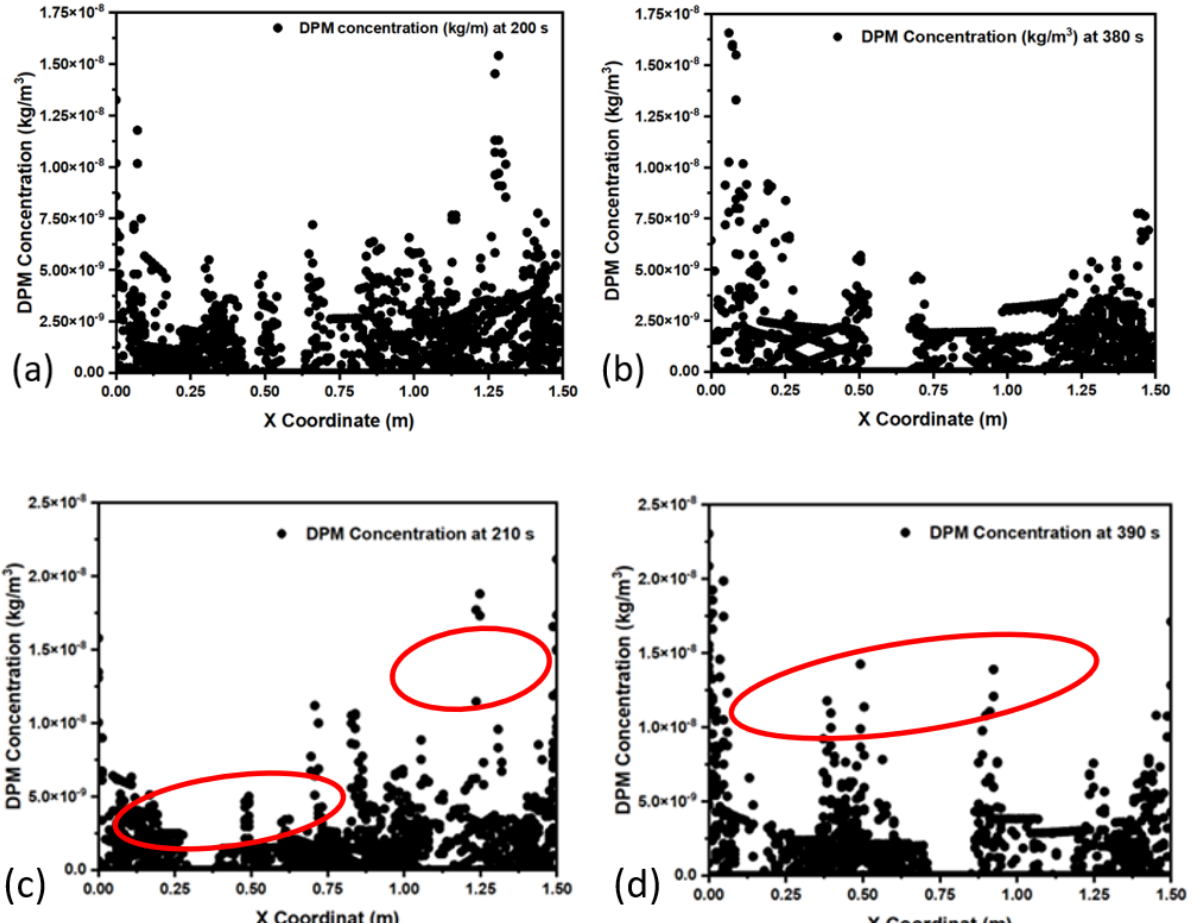
Figure 5. Inclusion (DPM) concentration in the mold at 1853 K; sizes: ( a , b ) 5-micron diameter and ( c , d ) 100-micron diameter.